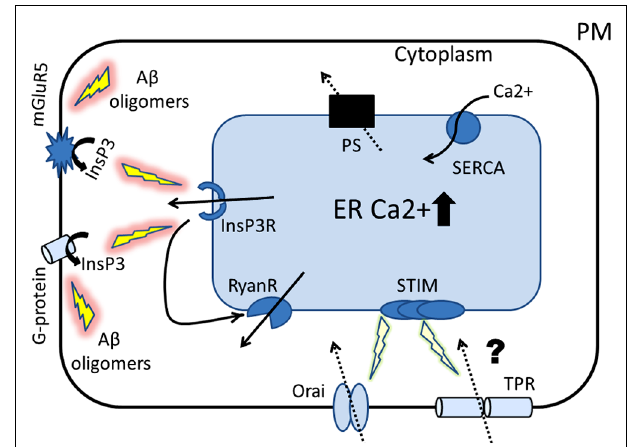
FIGURE 1 | Proposed role of ER Ca 2 + signaling in the pathogenesis of AD. The cartoon represents the Ca 2 + hypothesis of AD that places presenilins (PS) in the center of AD pathogenesis. Amyloid oligomers stimulate InsP3R-mediated Ca 2 + release from ER by activating synaptic mGluR5 receptors and by stimulating G-protein-mediated InsP3 production. Our laboratory has shown that presenilins function as ER Ca 2 + leak channels and FAD associated PS mutations disrupt this function, causing overloading of ER with Ca 2 + . Similar ER Ca 2 + overload occurs as a result of neuronal aging process.The first physiological response to ER Ca 2 + elevation is compensatory increase in expression and/or activity of inositol trisphosphate receptors (InsP3R) and ryanodine receptors (RyanRs).The second response to ER Ca 2 + overload is reduction in store-operated Ca 2 + (SOC) entry, a mechanism involved in refilling of ER Ca 2 + stores (mediated by Orai andTRP channels).We hypothesize that these initially compensatory and protective mechanisms of ER Ca 2 + signaling become pathogenic in aging neurons and eventually lead to synaptic dysfunction, synaptic loss and